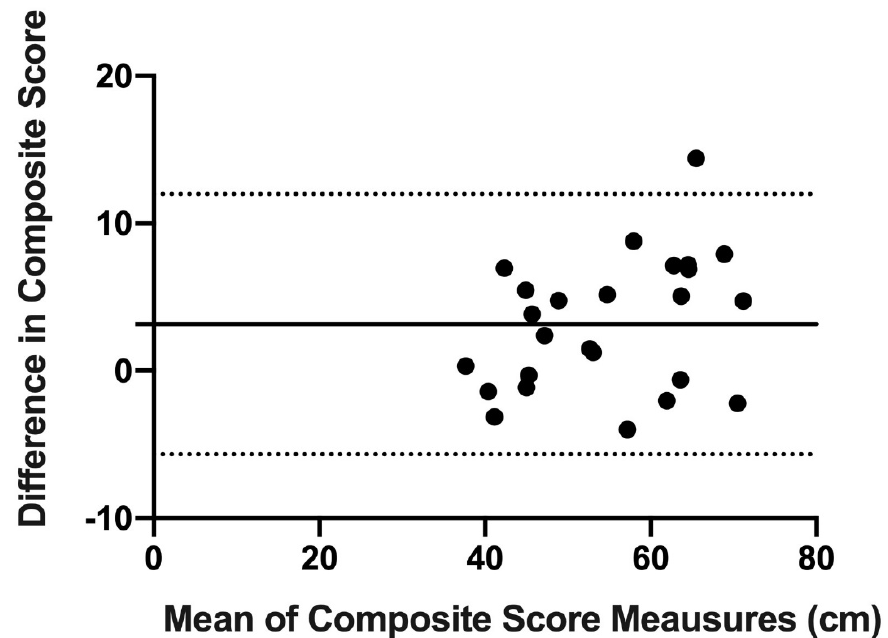
Figure 9. Bland–Altman right superolateral.